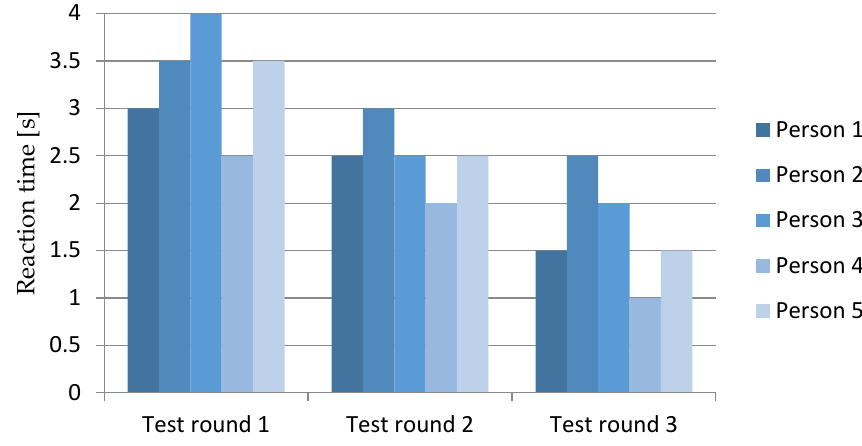
Figure 10. Reaction times of five test persons during three test drive rounds.